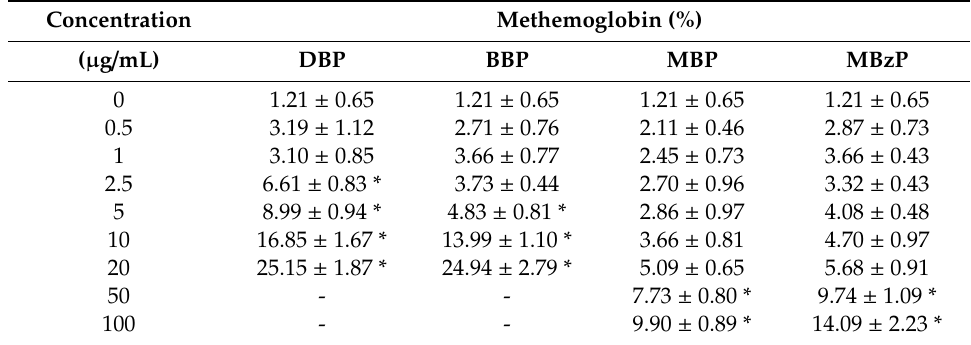
Table 1. Changes in methemoglobin level in control erythrocytes and in erythrocytes incubated for 24 h with DBP, BBP, MBP, and MBzP used at concentrations ranging from 0.5 to 100 µ g / mL.